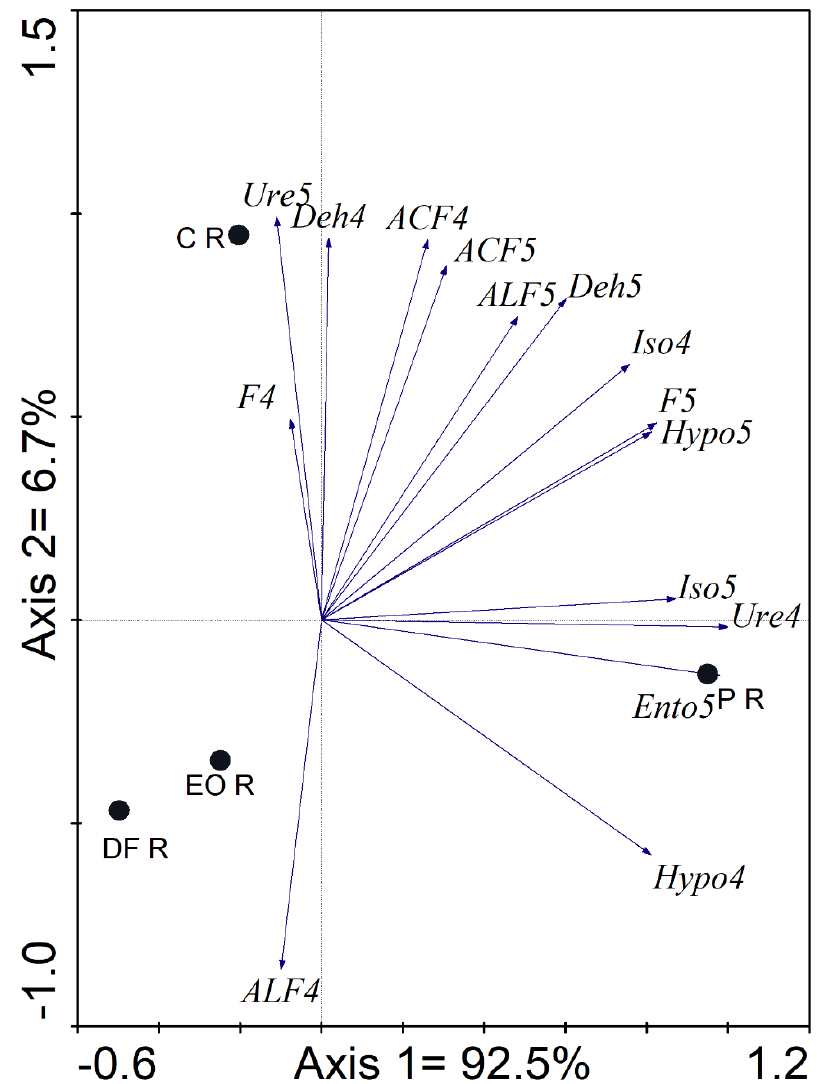
Figure 7. Principal component analysis of soil enzyme activity and soil fauna occurrence in soils with ZB-01 application. ACF4—acid phosphatase activity after 4 years, ACF5—acid phosphatase